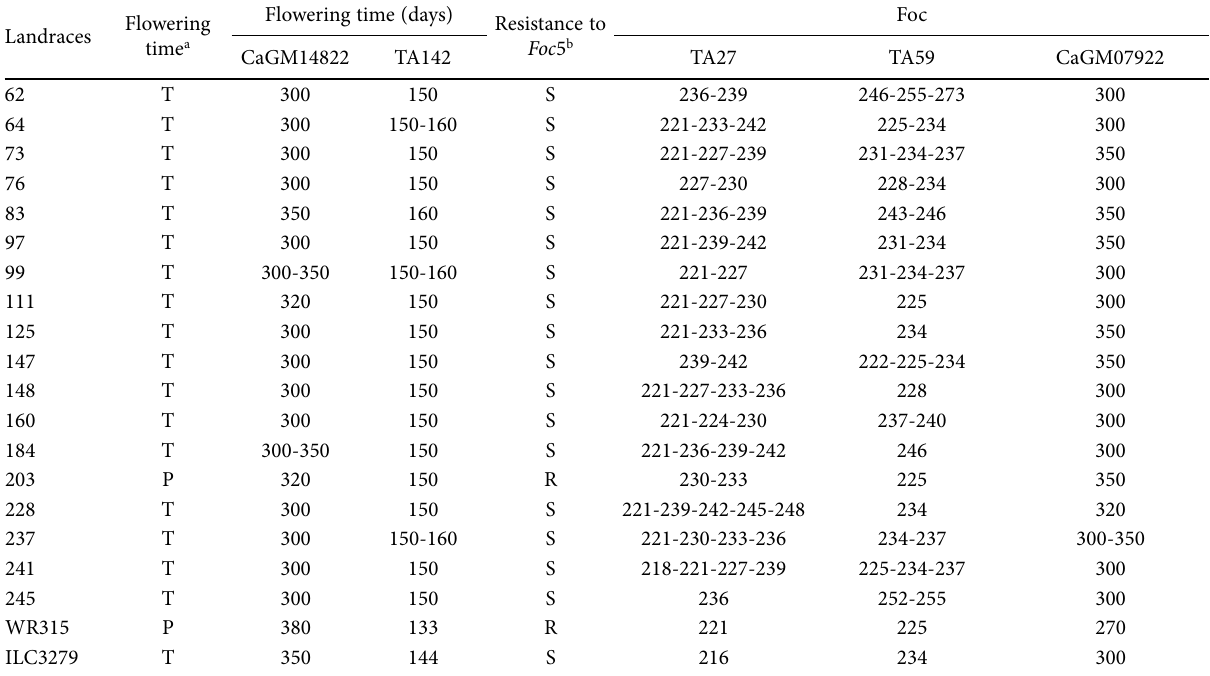
Table 3. Associations between phenotypic data for flowering and resistance to Foc 5 with microsatellite marker alleles found in the 18 Ital- ian chickpea landraces. Microsatellite markers associated with flowering time were CaGM14822 and TA142, and with resistance to Foc were TA27, TA59 and